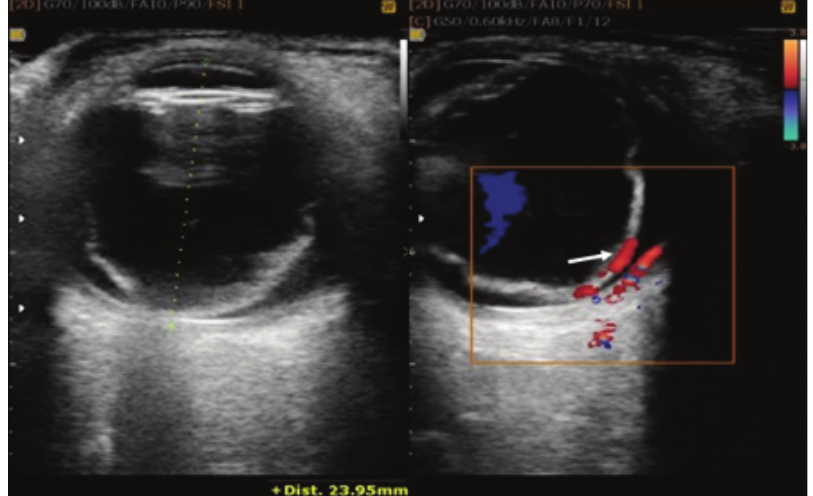
Figure 1. (Left) The funnel-shaped membrane has been marked on the gray-scale B scan. (Right) The figure shows arterial flow and retinal detachment.